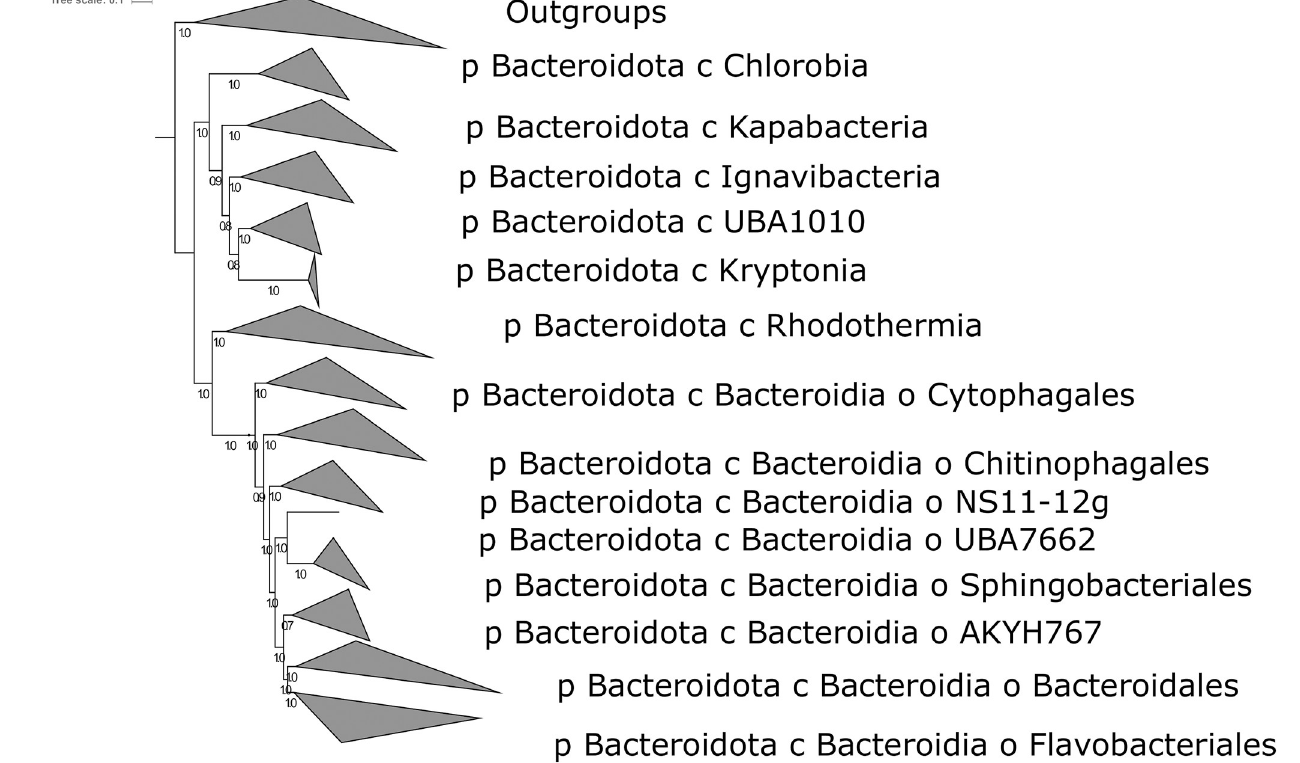
Fig 1. Phylogeny of the Bacteroidota built with concatenated ribosomal proteins and labeled with clade names (classes, and orders within Bacteroidia) derived from GTDB-Tk. The Chlorobia (formerly Chlorobi) are positioned as a class within the broader Bacteroidota phylum, and not as a separate phylum as previously